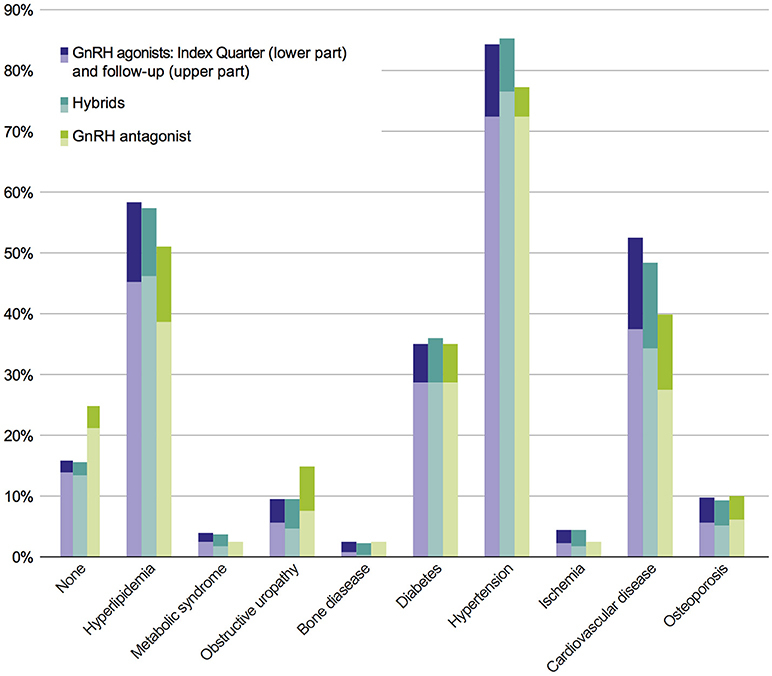
Prevalence of comorbidities of the adjusted population in pooled therapy classes. Each bar indicates prevalence of comorbidities in index period (lower part) + 2 years follow-up (upper part).